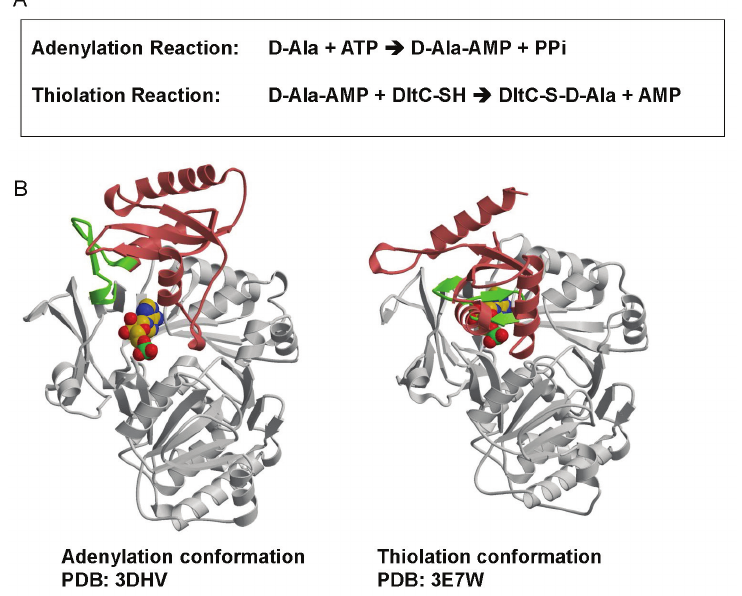
Figure 1. Structure and function of DltA. A . A two-step reaction catalyzed by DltA. B . The adenylation and thiolation conformations of DltA. In the first adenylation reaction, D-alanine is converted into DltA-bound D-alanine adenylate (D-Ala-AMP). This reaction is catalyzed by the adenylation conformation of DltA shown as DltA/AMP complex. In the subsequent thiolation reaction, the activated alanyl group in the intermediate is transferred to the thiol group of DltC-linked 4’-phosphopantetheine (DltC-SH). The second reaction is catalyzed by the thiolation conformation of DltA shown also as DltA/AMP complex. Most part of the major N-terminal domain of DltA (residues 2 - 399) is shown in gray. The majority of the minor C-terminal domain of DltA (residues 400–504) is shown in salmon. Residues between Arg-397 and Glu-413 are highlighted in